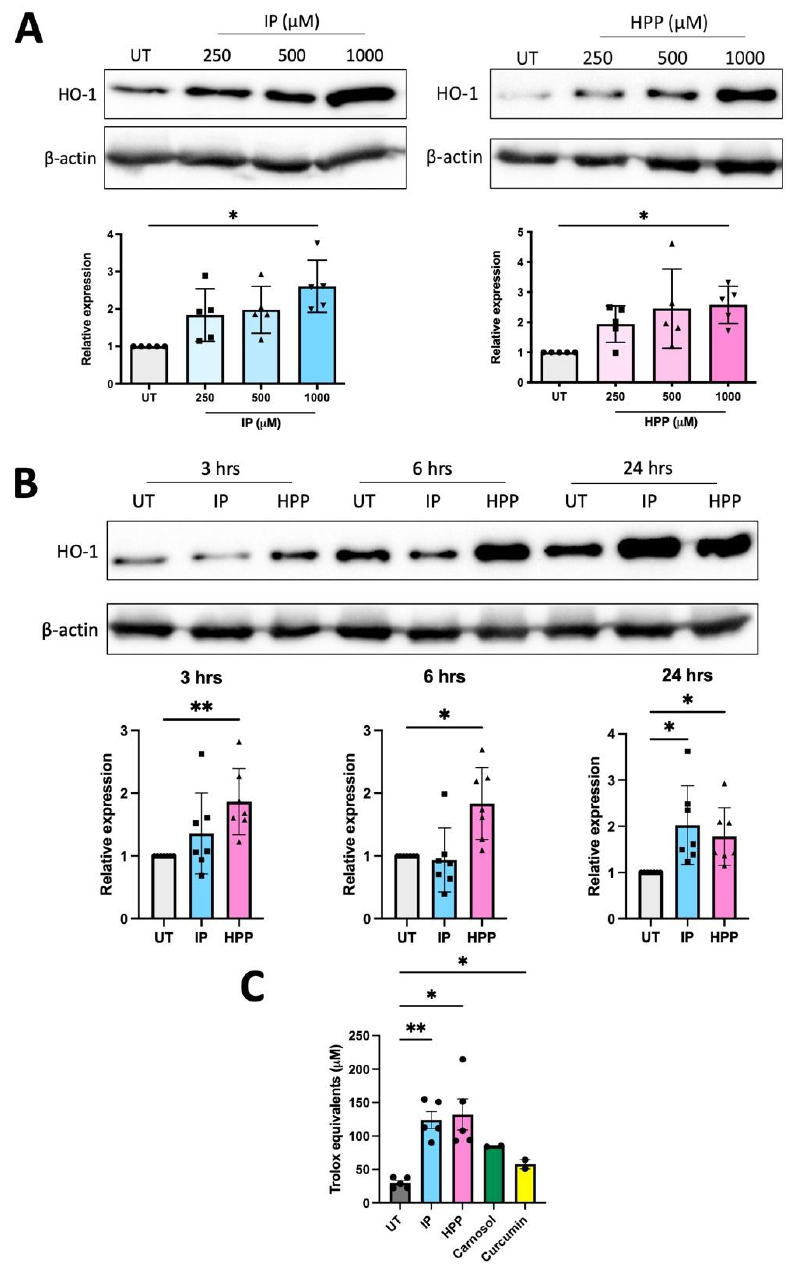
Figure 1. Hydroxyphenylpyruvate (HPP) and indole pyruvate (IP) upregulate HO-1 in primary human dendritic cells (DC). ( A ) Primary human DC were left untreated (UT) or incubated with HPP or IP (250–1000 µ M) for 24 h. HO-1 expression was detected by western blot. Densitometry results shown are mean ± SEM of the relative expression of HO-1: β -actin from five healthy donors. ( B ) DC were left UT or incubated with HPP or IP at 1000 µ M for 3, 6, or 24 h. HO-1 expression was detected by western blot. Densitometry results shown are mean ± SEM of the relative expression of HO-1: β -actin from seven healthy donors. ( C ) Primary human DC were left UT or incubated with HPP or IP at 1000 µ M, or carnosol or curcumin (both 10 µ M), for 1 h. Total antioxidant capacity of the cells was determined and expressed as an equivalent concentration of Trolox ( µ M). Pooled data showing the mean ( ± SEM) from five healthy donors. Repeated measures one-way ANOVA, with Dunnett’s multiple comparisons post hoc test, was used to determine statistical significance by comparing means of treatment groups against the mean of the control group (** p < 0.01, * p < 0.05). ImageLab (Bio-Rad) software was used to perform densitometric